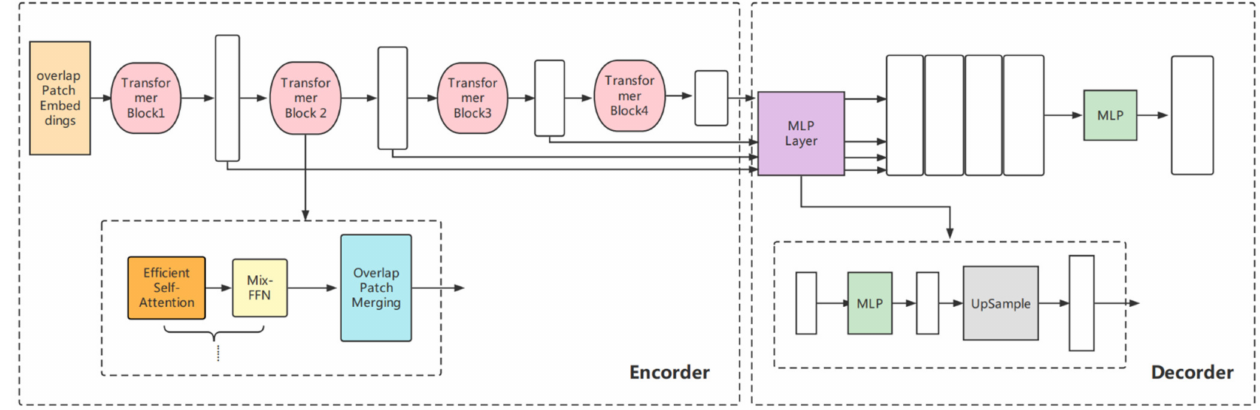
Figure 3. Proposed lightweight transformer